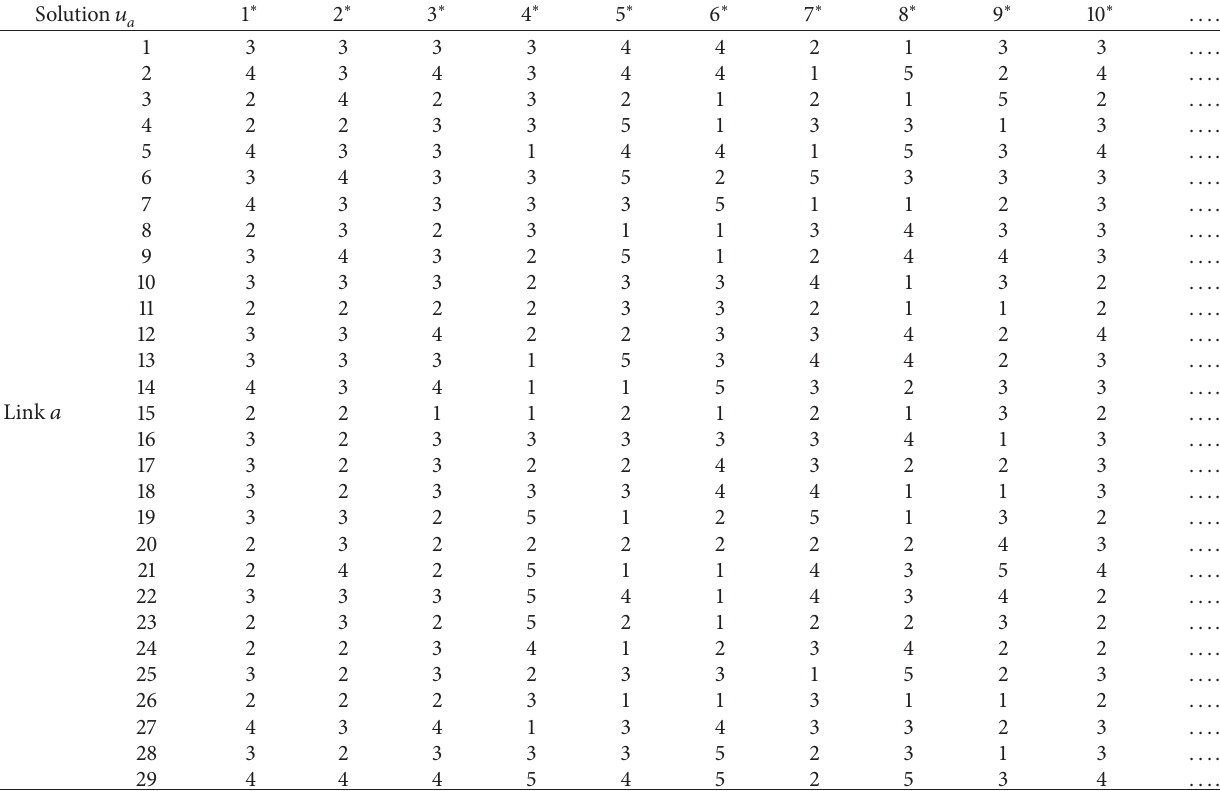
Table 6: Pareto optimal solution set on the upperlevel.